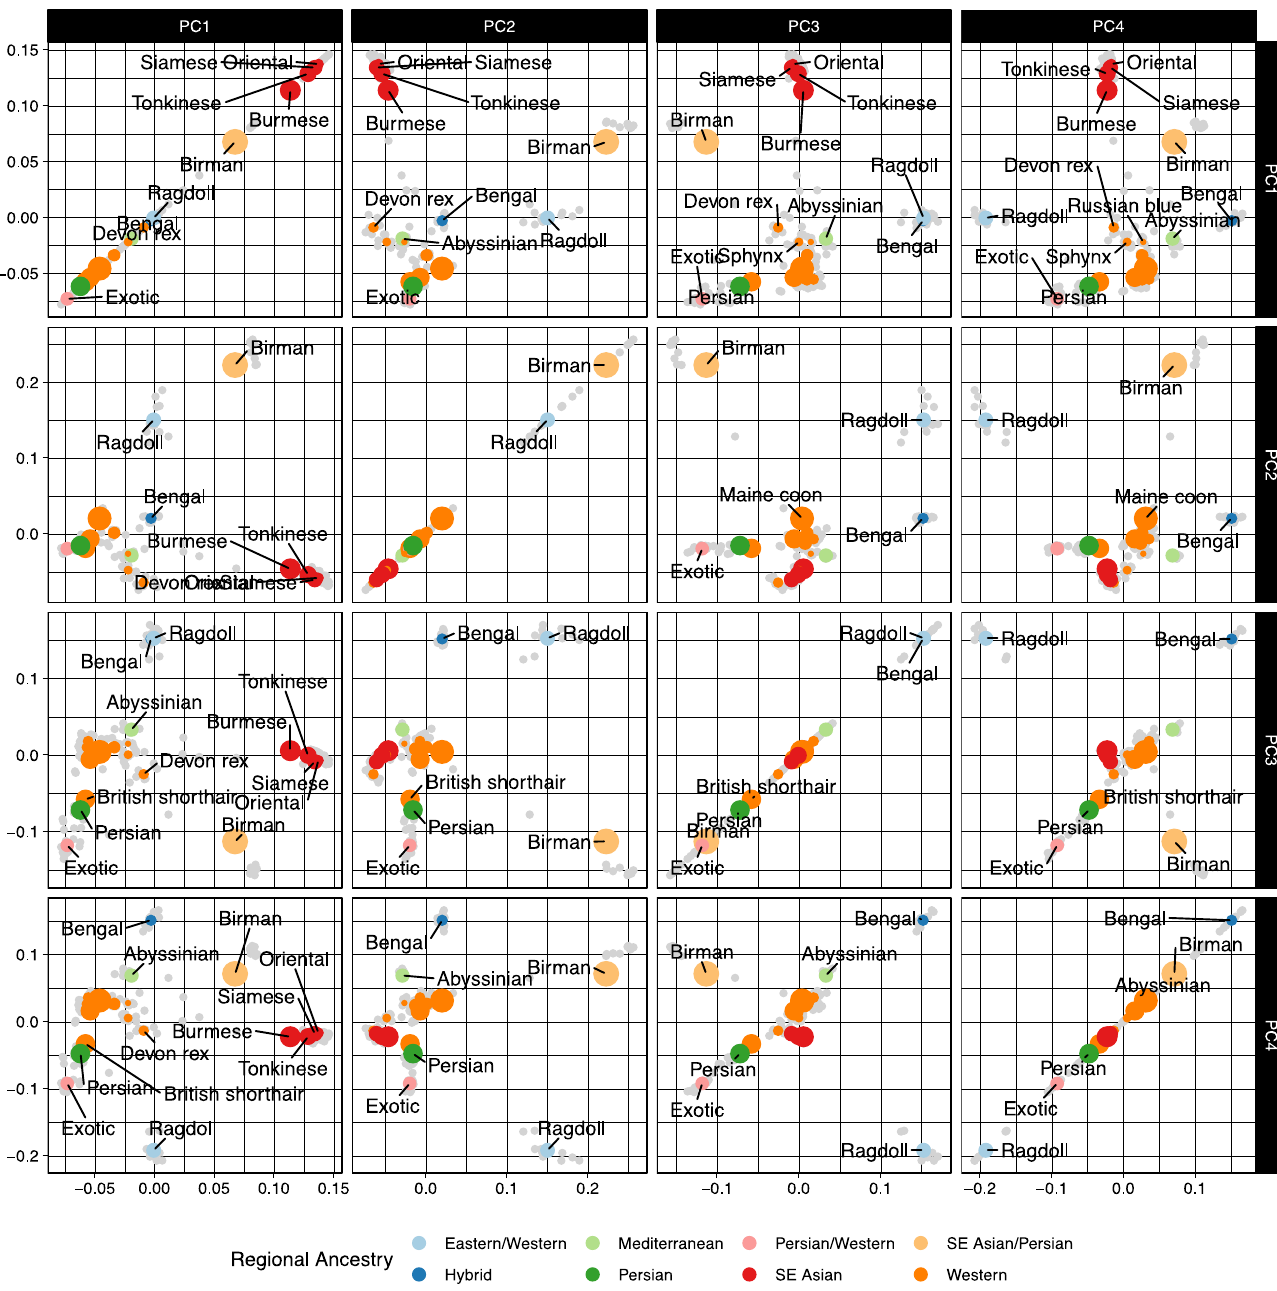
Figure A4. Combinations of PC1-PC4 for the balanced dataset. Coloured points reflect regional ancestry while the circle size reflects the maximal standard deviation across the depicted PCs.